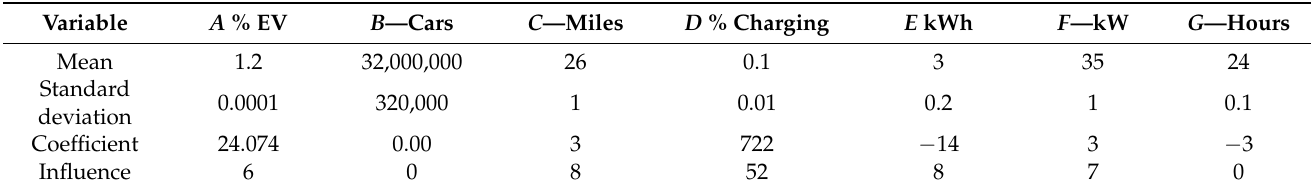
Table 2. Variance